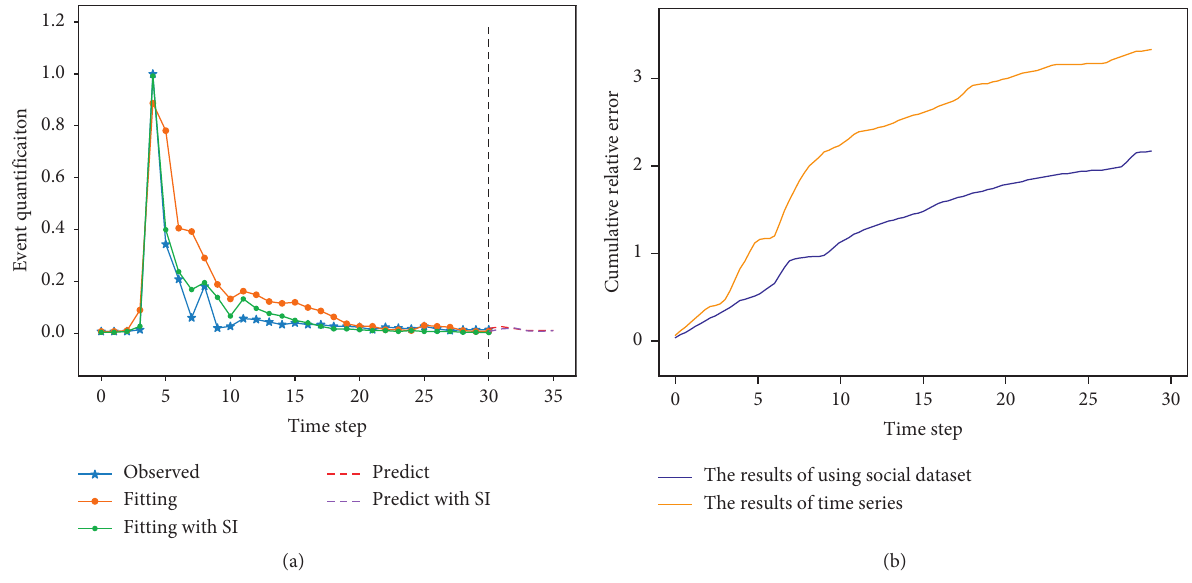
Figure 10: Popularity evolution prediction of entertainment event: “Baihe Bai derailed.” (a) Prediction accuracy comparison. (b) Cu- mulative relative error analysis. A similar prediction result is obtained concerning a slightly rising error compared with Figure